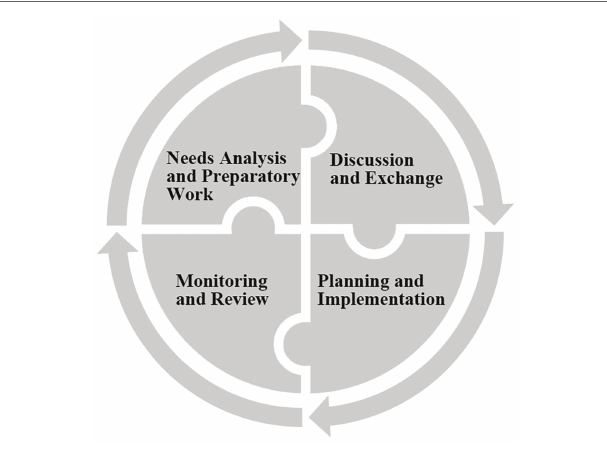
FIGURE 1 | Four critical stages in the CCD